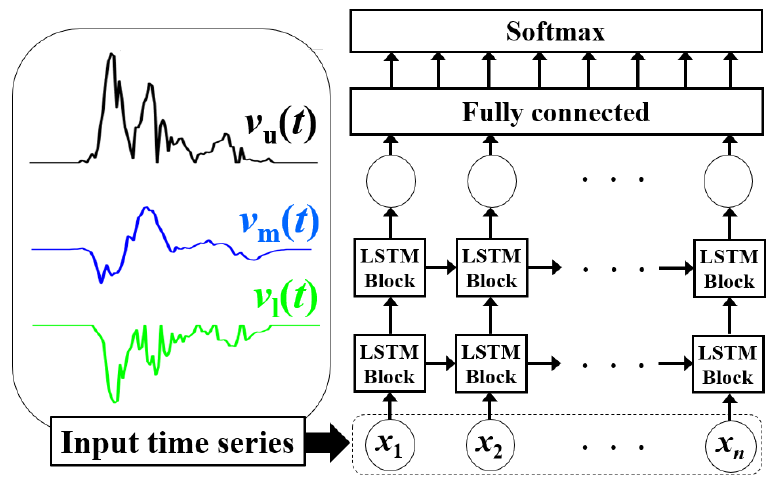
Figure 5. Example of extraction of spectrogram envelopes.